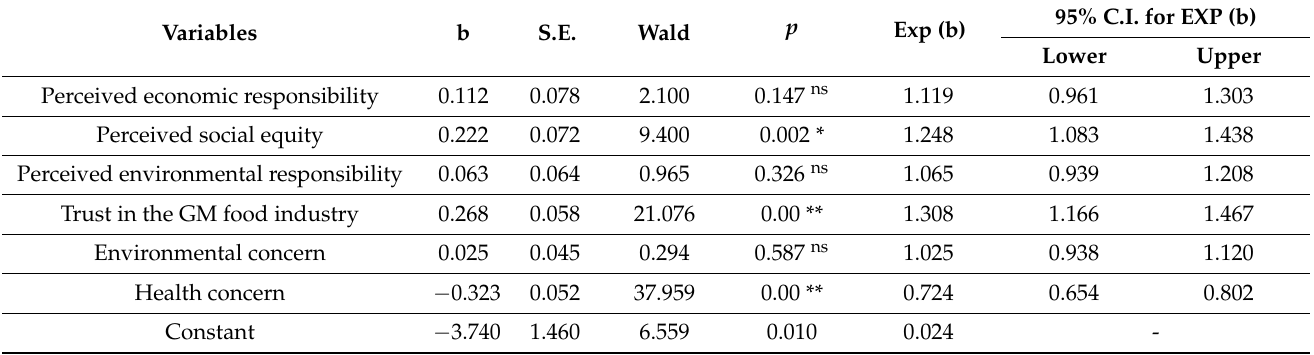
Table 5. Binomial Logistic Regression Analysis for six